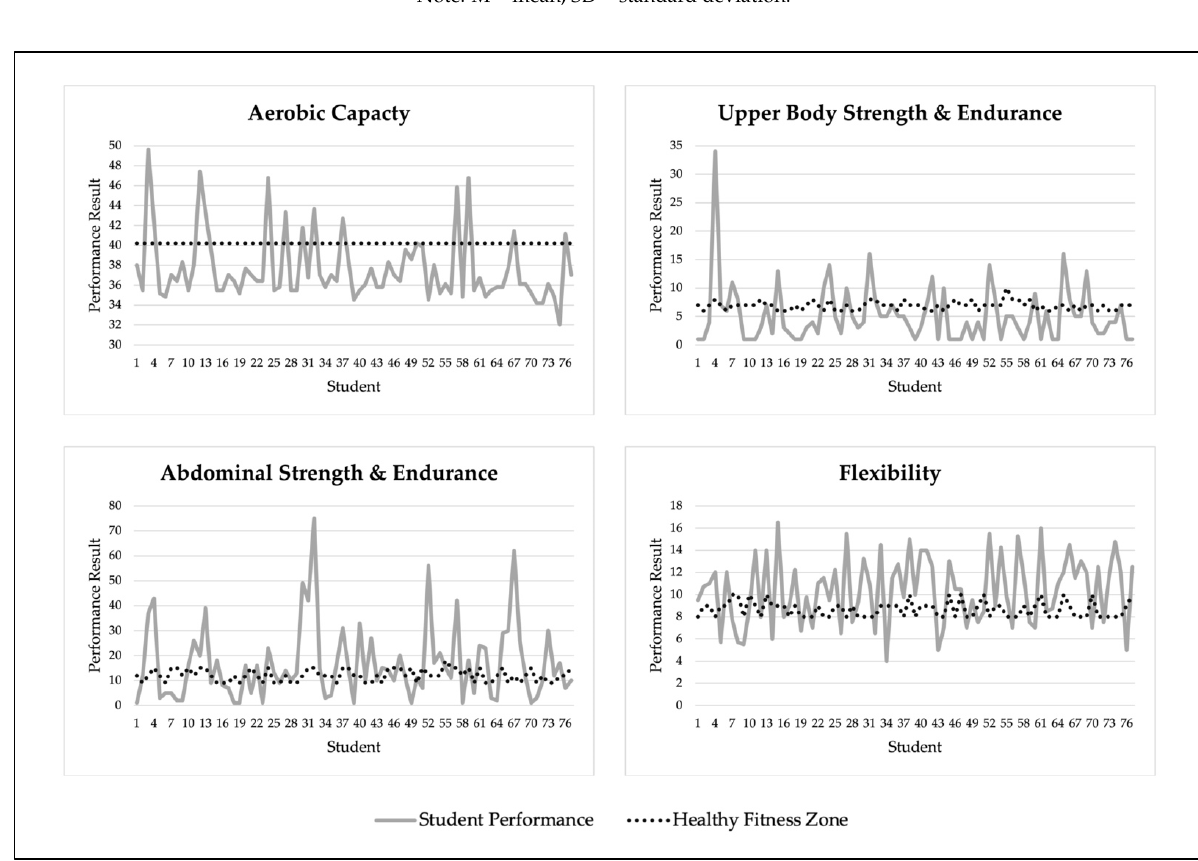
Figure 1. Results for Student Performance. Only 16.9% of students achieved the HFZ for aerobic capacity (7.7% of female stu- dents and 26.3% of male students), with 64.9% and 18.2% falling in the NI–HR and NI categories, respectively. Less than a third of students (31.2%) achieved the HFZ for upper body strength and endurance (33.3% of female students and 28.9% of male students) and just over half of students (55.8%) achieved the HFZ for abdominal strength and endurance (59% of female students and 52.6% of male students). More than two-thirds of students (68.8%) achieved the HFZ for flexibility (64.1% of female students and 73.7% of male stu- dents). 4. Discussion A large number of studies have examined the prevalence of children living in low- income families and their risk factors (e.g., obesity, bad eating habit, depression, etc.), and the importance of health-related fitness among children was significantly highlighted [5,20,43,44]. Therefore, this study aimed to investigate the health-related fitness levels of Title I elementary school students by utilizing four assessments of FitnessGram [28]. Student assessment results indicated aerobic capacity as the component of greatest concern, with less than 17% of students achieving the HFZ. This is consistent with Burns et al. [45], who found children in low-income schools performed poorly on assessments of aerobic capacity, leading to increased risk of cardiometabolic diseases. Similarly, Bai and colleagues [46] found that HFZ achievement for aerobic capacity of FitnessGram as- sessment is positively associated with students’ minority rate and low socioeconomic sta- tus. Beyond the important connections between aerobic capacity and physical health, high cardiorespiratory fitness is associated with stronger cognitive performance in children